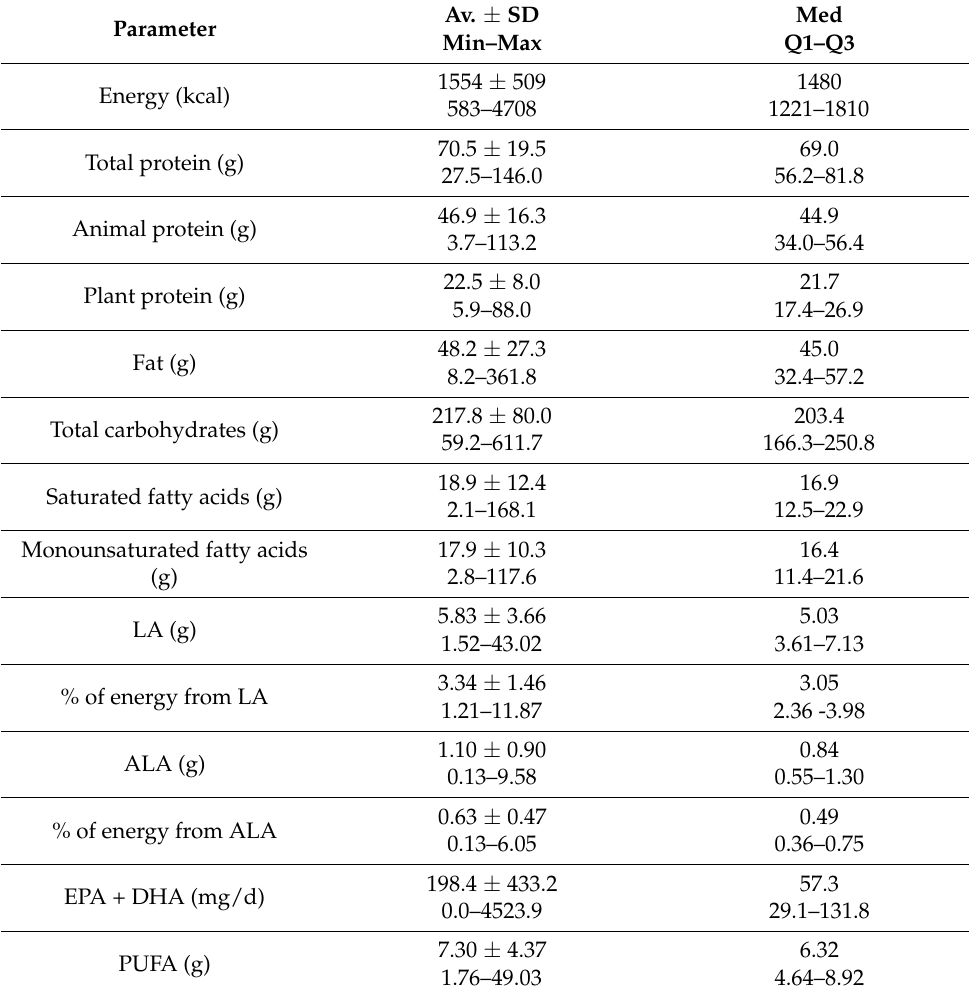
Table 3. Consumption of selected